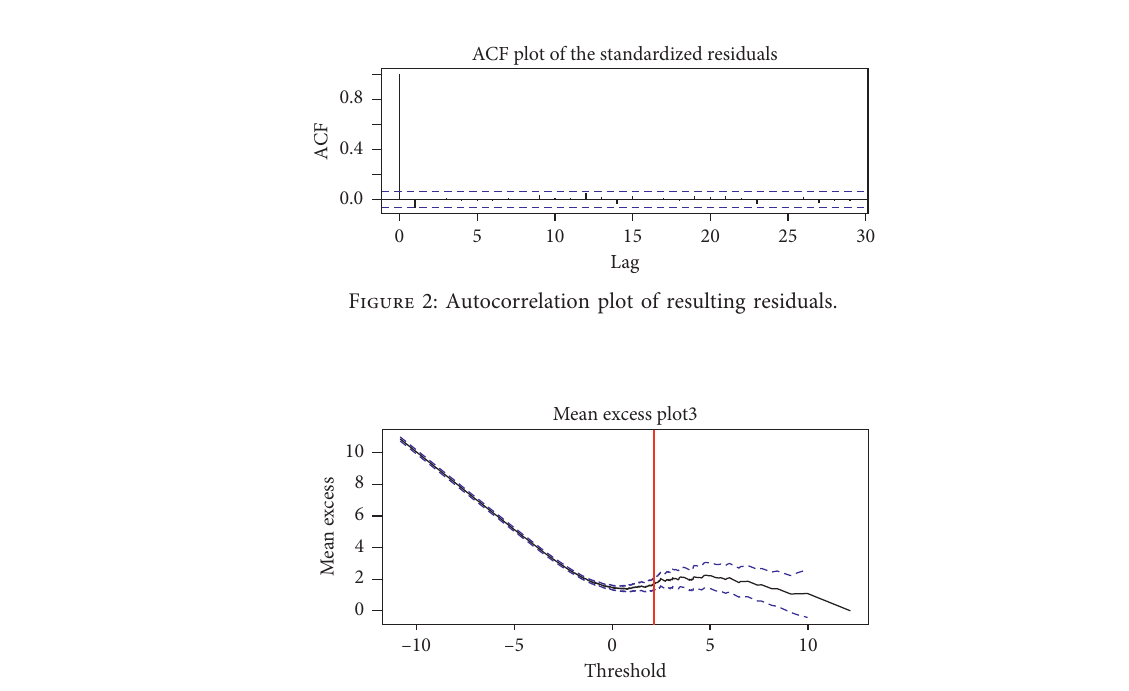
Figure 3: Mean excess plot.